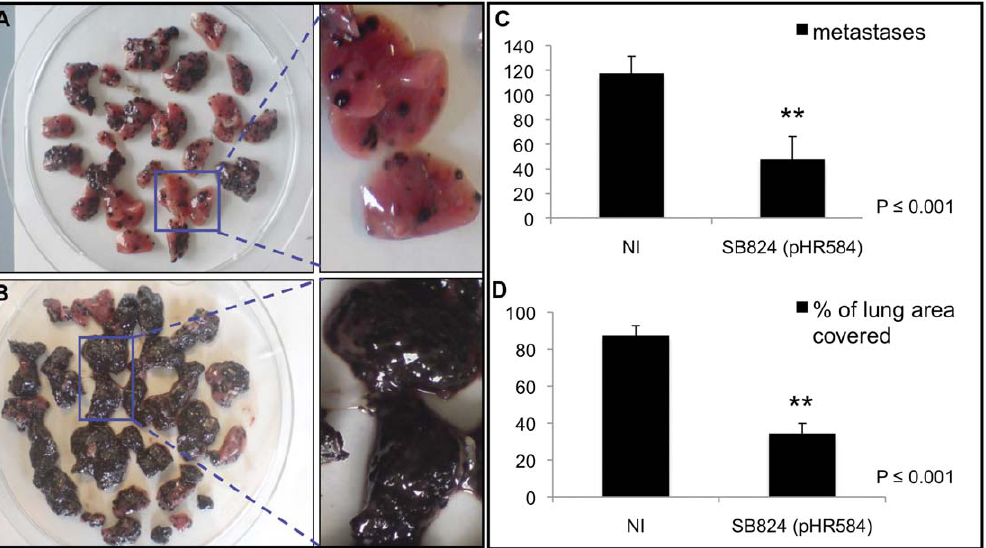
Figure 6. Analysis of lung metastasis after Salmonella -mediated vaccination against VEGFR2. A In the artificial lung metastasis model, C57Bl/6 mice were orogastrically vaccinated with SB824 (pHR584) followed by a tumor challenge with an intravenous injection of B16 melanoma cells on day 30 in order to mimic the metastatic process. Lungs of ten mice vaccinated with SB824 (pHR584) and magnification of single lobes are displayed. B Lungs of ten non-immunized mice and magnification of single lobes. C Average number of metastatic spots on lungs (**, p # 0.001) D Average percentage of surface area of the lungs covered with metastases (**, p # 0.001). Each experiment was performed at least twice with similar results.